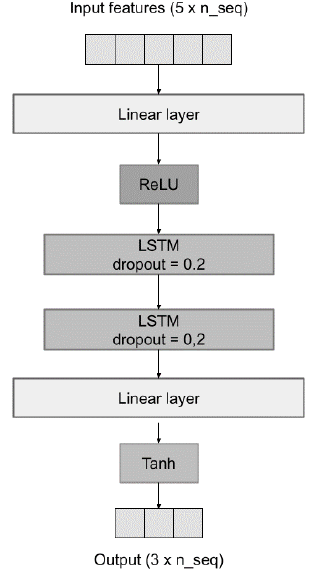
Fig. 2. The original LSTM architecture.